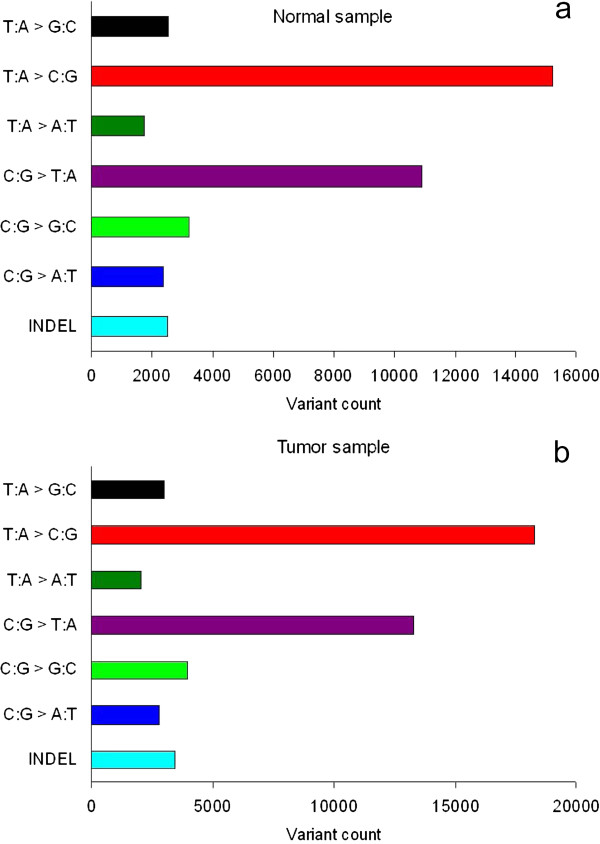
Mutation spectra of normal and tumor tissues. The numbers of each of the six classes of base substitution and insertion/deletions are shown. a. The pattern in normal samples. b. The pattern in tumor samples.